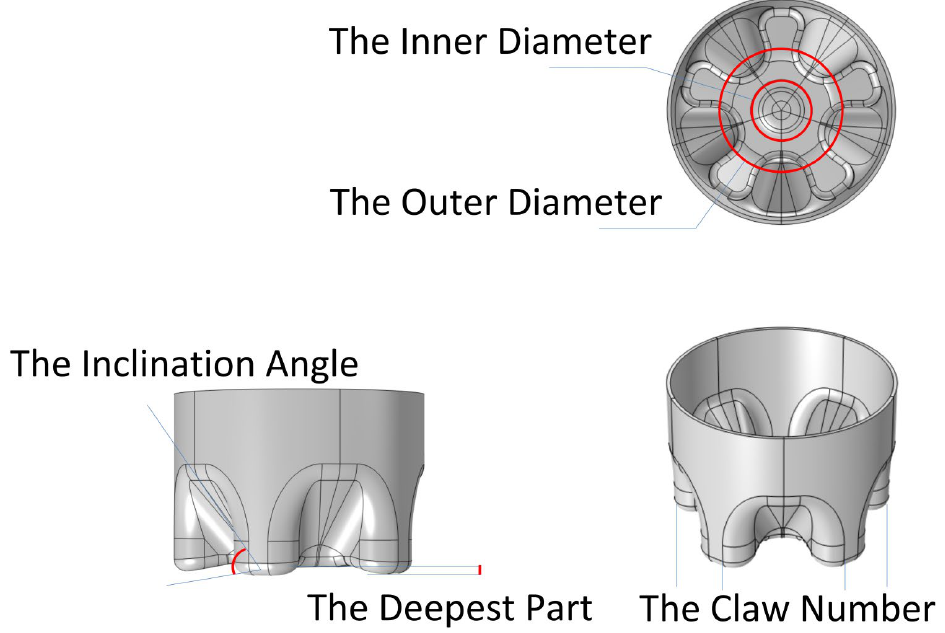
Figure 3. Common adjustable parameters of bottle bottom.